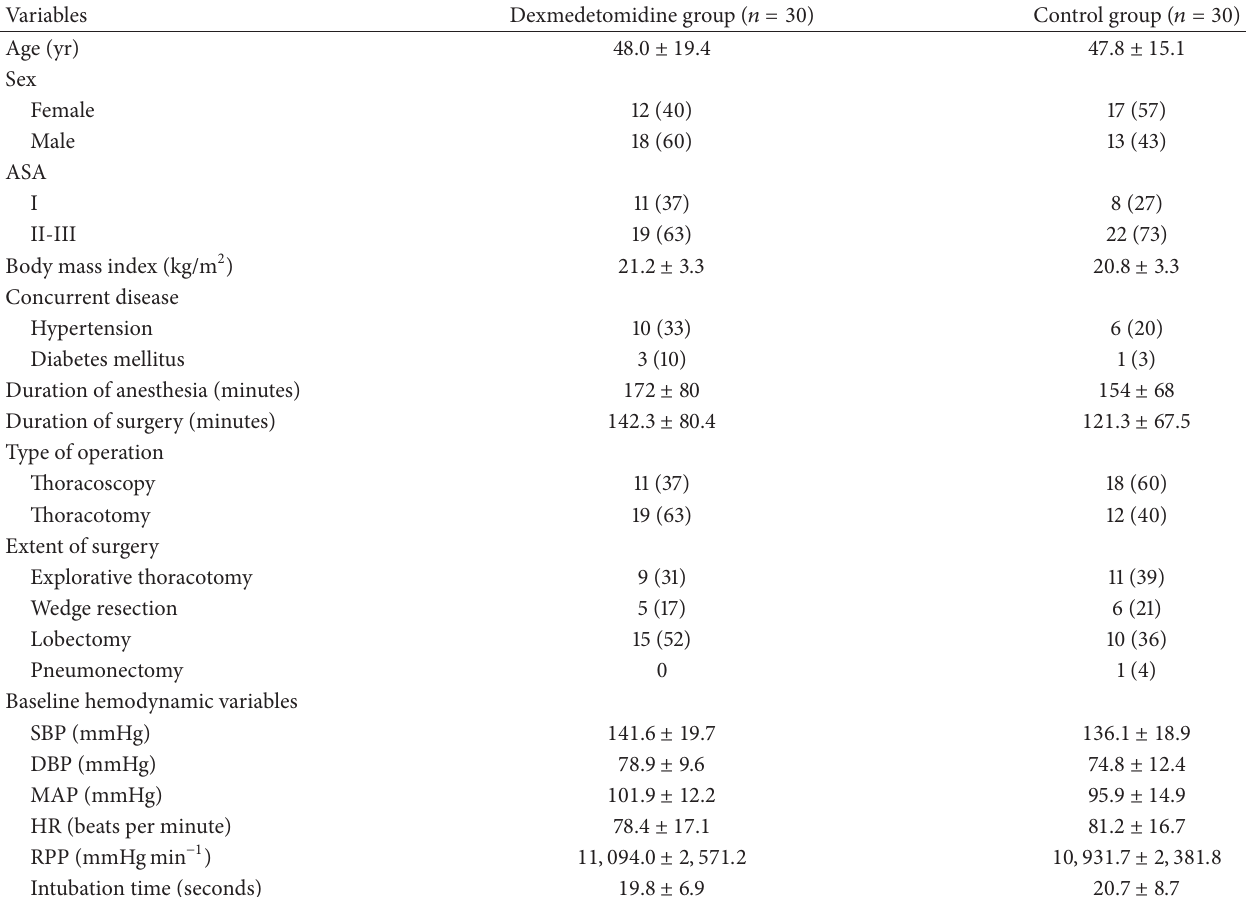
Table 1: Patient characteristics and operative